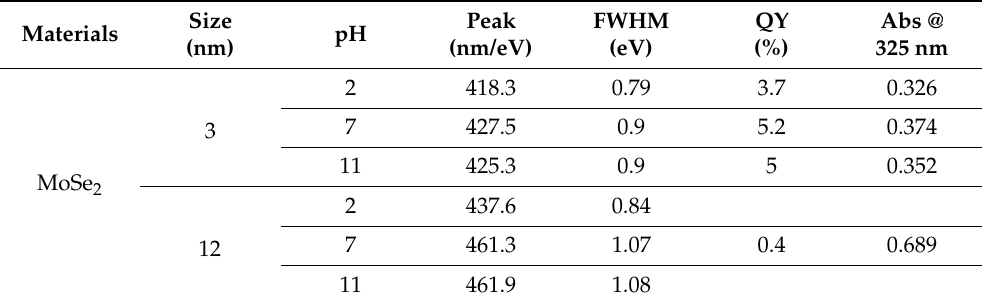
Table 1. Phtotophysical parameters of MoSe 2 - m